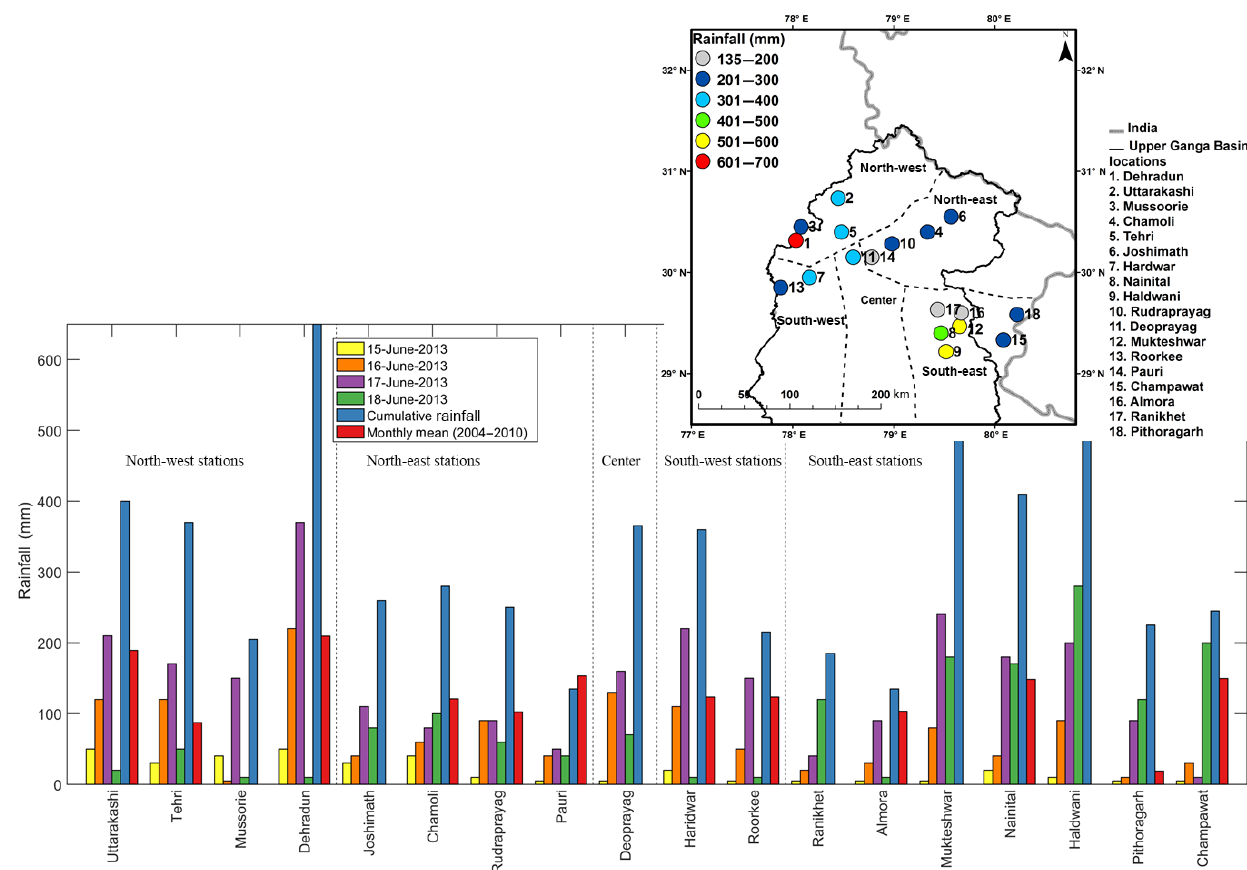
Figure 2. Observed daily and cumulative rainfall along with historic monthly mean (2004–2010) values at the 18 rain gauges in the upstream region of the UGB. Table 2. Heavy to extremely heavy rainfall events recorded in the UGB region. Event